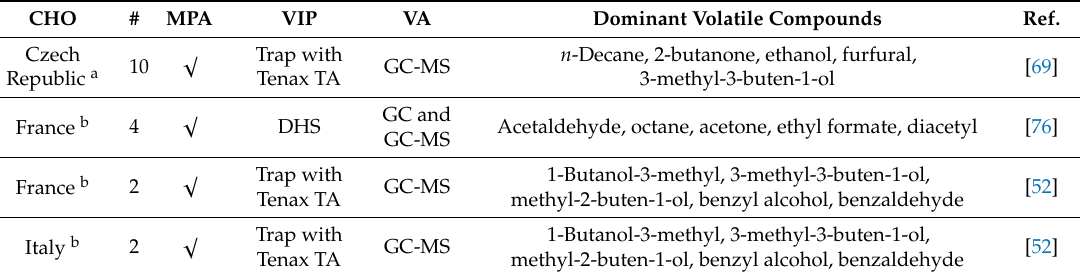
Table 20. Sunflower honey’s main volatiles, with reference to the country of origin, number of samples, isolation and analysis procedures and five main volatile components. Unless otherwise specified, the honeybee type was A. mellifera